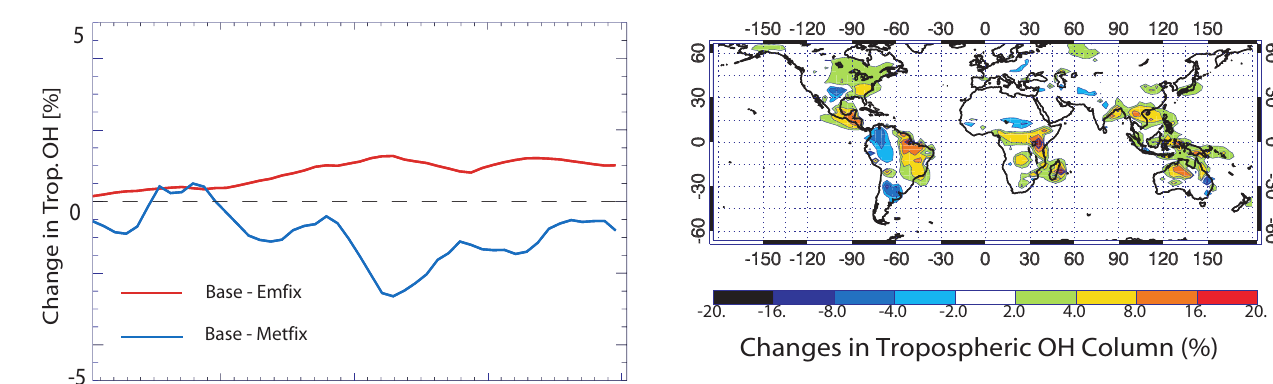
Fig. 5. Differences in tropospheric OH column between the Emfix and Base runs averaged over 1992. This corresponds to the differ- ence between using 1992 and 1990 isoprene